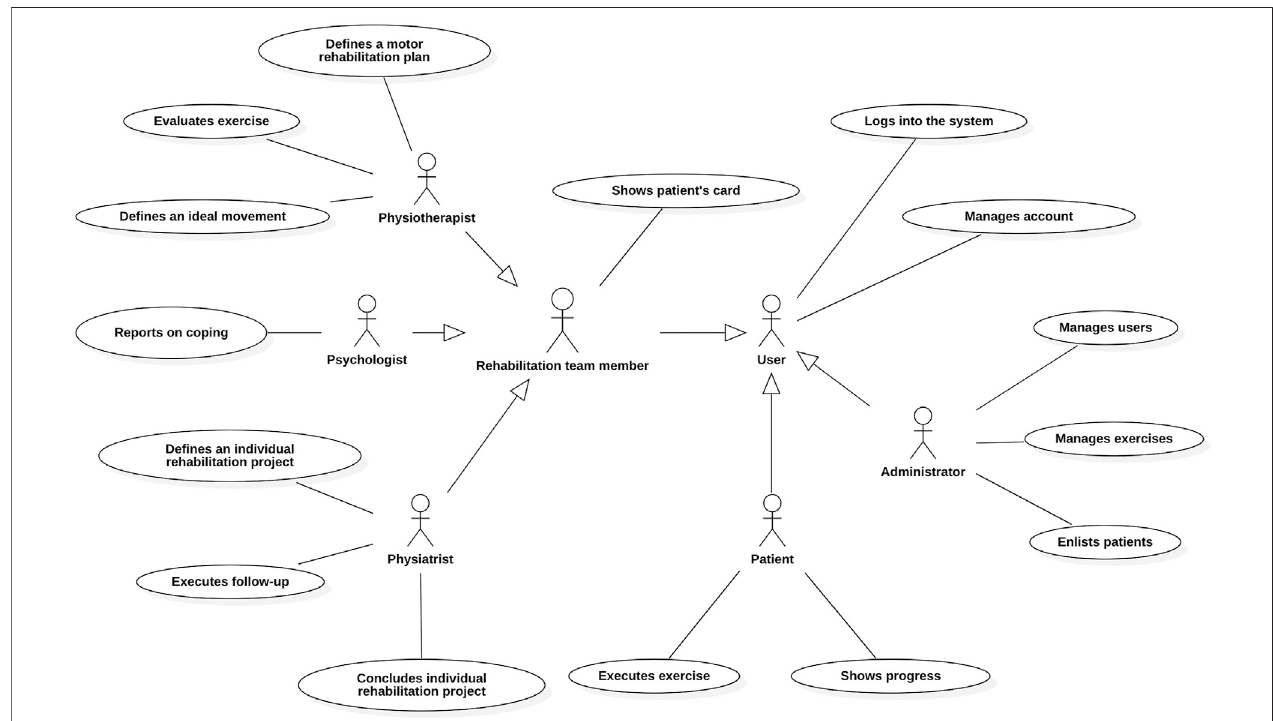
FIGURE 1 | 2Vita-B Physical: End-users